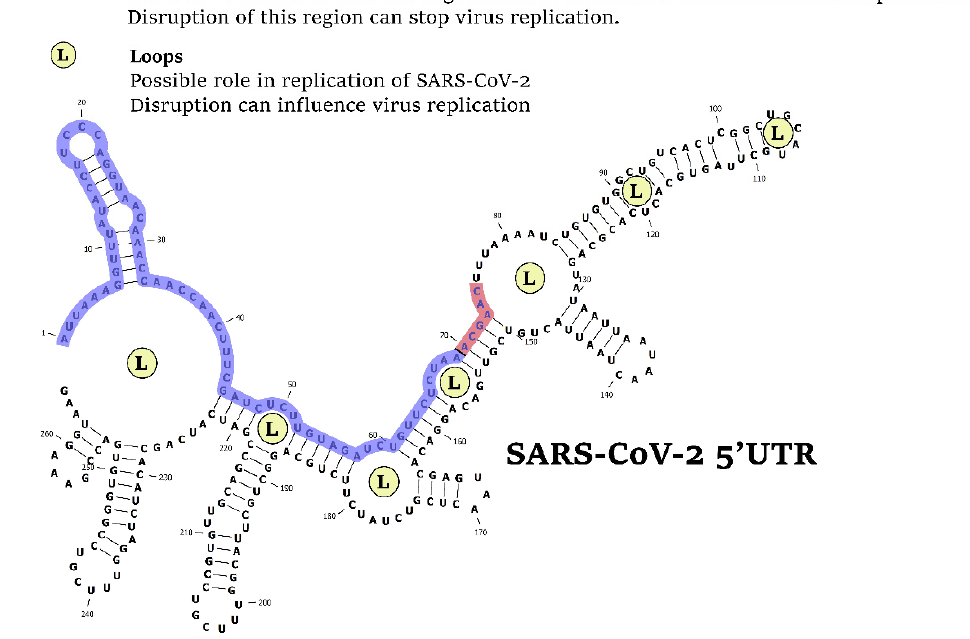
Figure 1. The 5 (cid:48) UTR is the Achilles’ heel of SARS-CoV-2. Disruption of specific regions in 5 (cid:48) UTR, including leading Figure 1. The 5’UTR is the Achilles' heel of SARS-CoV-2. Disruption of specific regions in 5’UTR, including leading sequence, transcription regulatory sequence, or loops (L) can stop the virus rep- sequence, transcription regulatory sequence, or loops (L) can stop the virus lication.